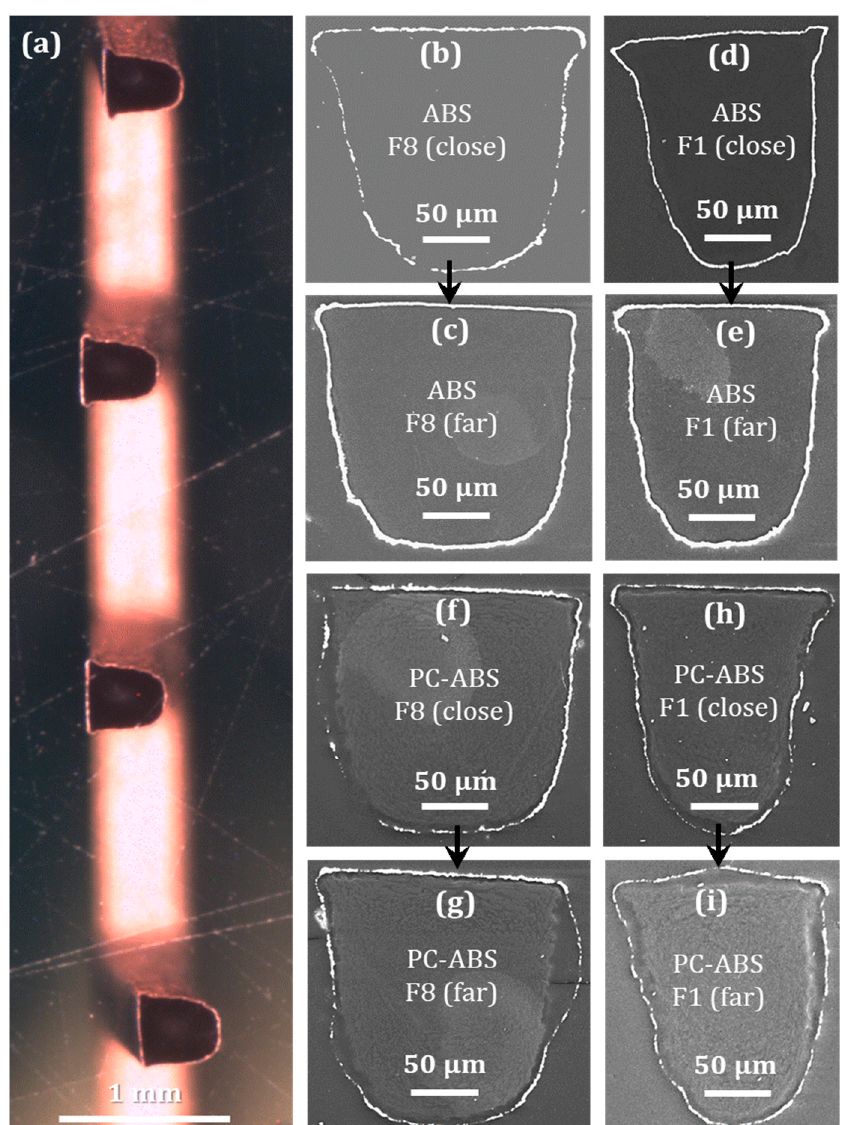
Figure 8. Epoxy molded and grinded sections of micro fingers ( a ). Quality and thickness of Cu coat- ings on ABS part ( b – e ) and PC-ABS part ( f – i ) at different fingers and heights (close to the base and far from the